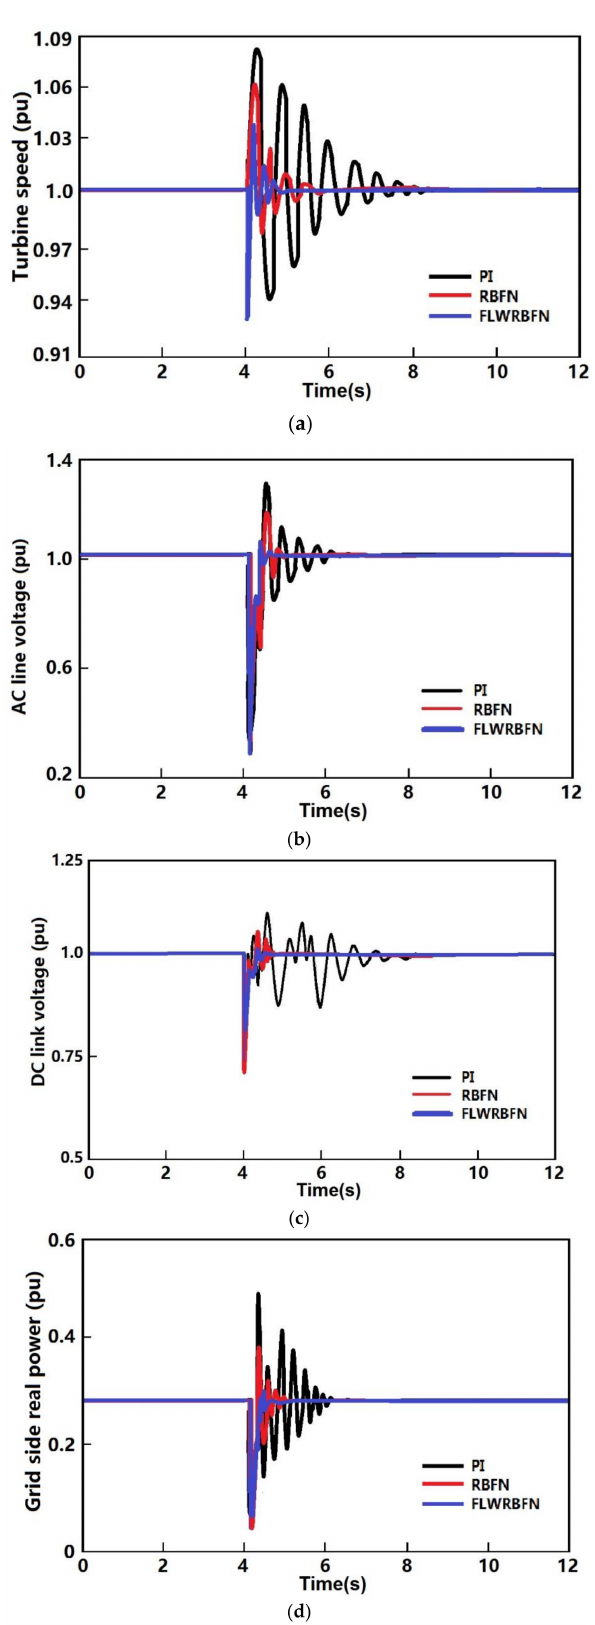
Figure 5. The transient simulation results of the studied system under short circuit: ( a ) Turbine speed; ( b ) AC line voltage; ( c ) DC link voltage; ( d ) Grid side real